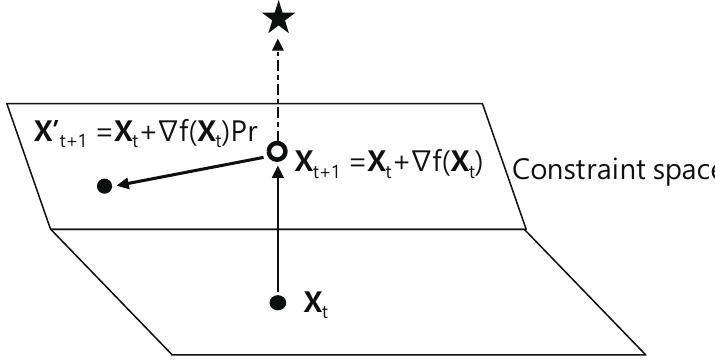
Figure 4. The comparison of the throughput according to the SF